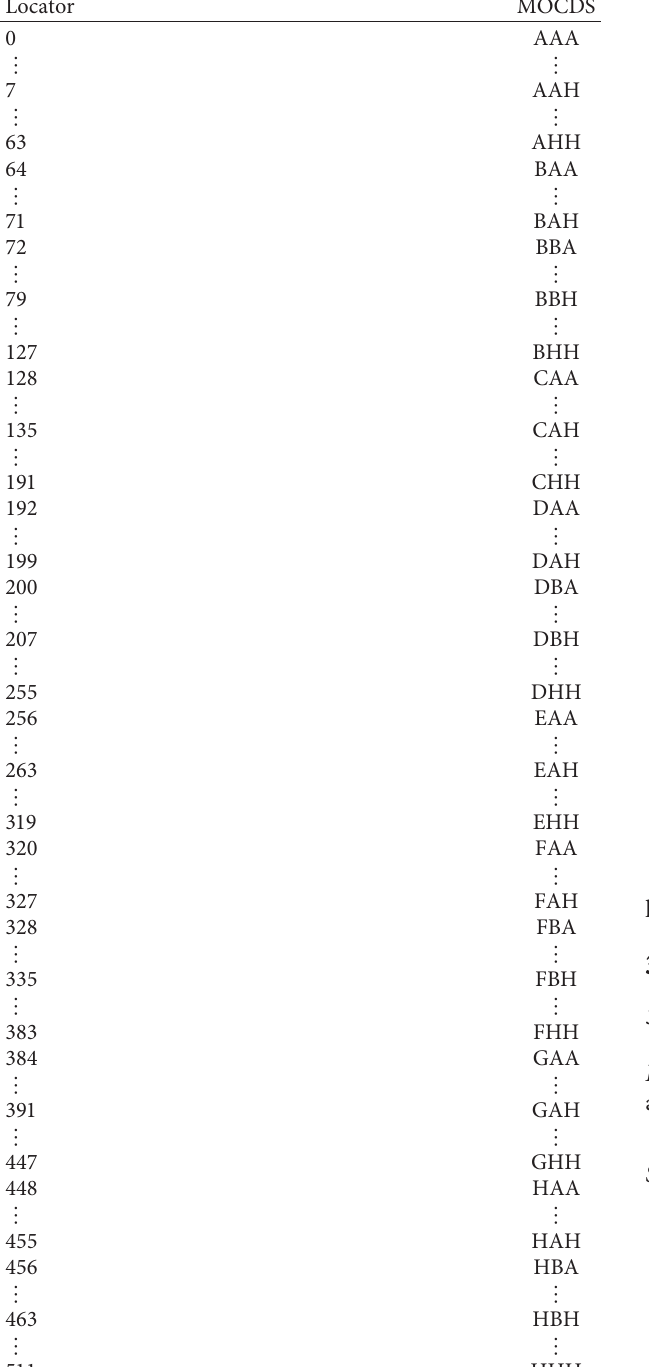
Table 4: Minimum outer-convex dominating sets of G , where n � 3.